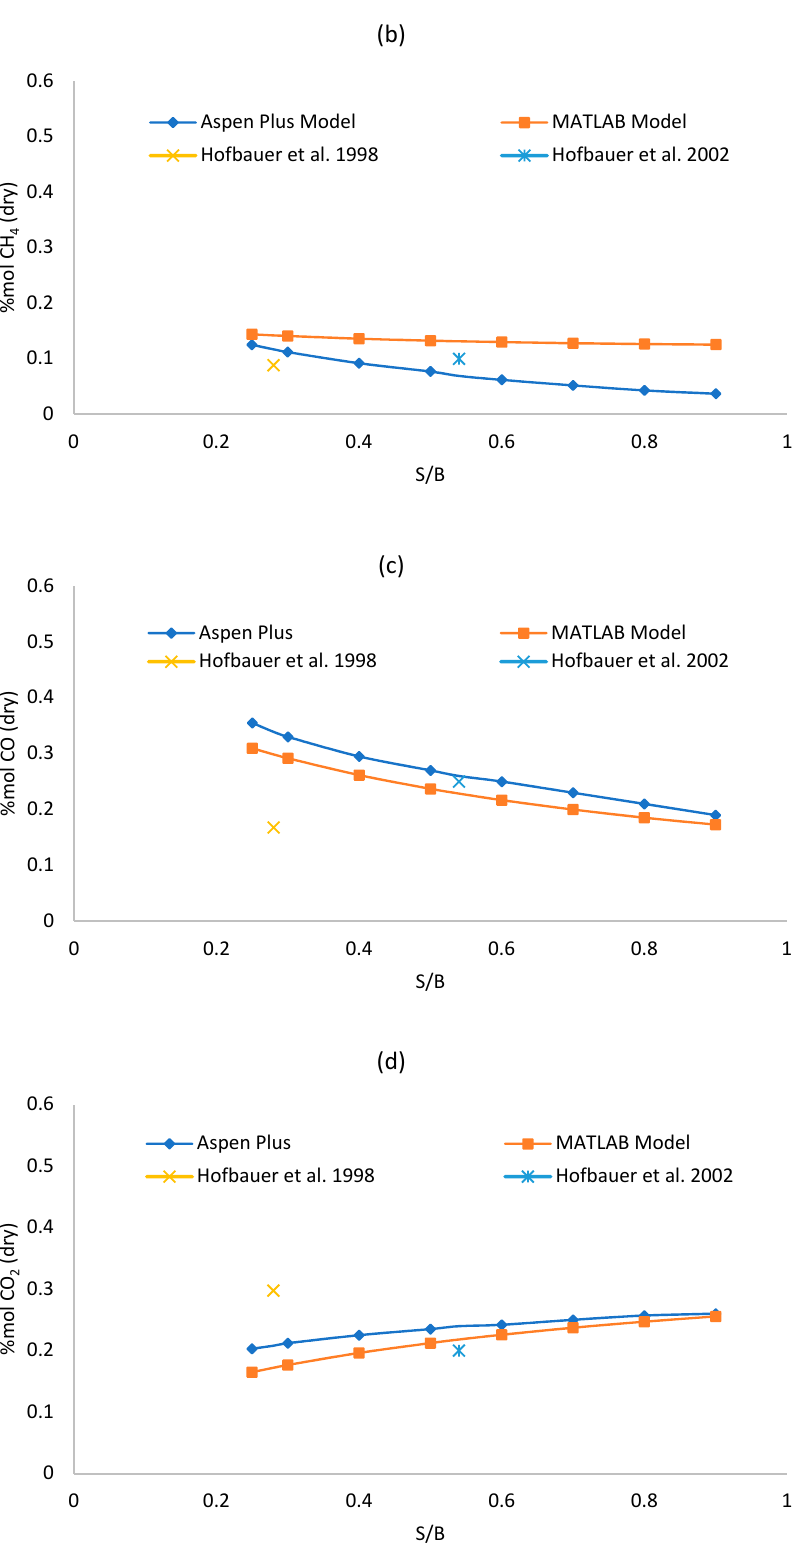
Figure 3. ( a – d ) Effect of S/B ratio on syngas ( a ) hydrogen, ( b ) methane, ( c ) carbon monoxide; ( d ) carbon dioxide dry mole fraction.